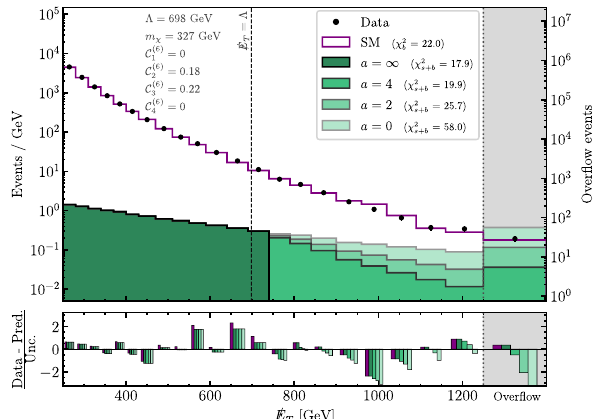
Fig. 9 Top panel: Examples of missing energy spectra for the CMS monojet search [95], illustrating different choices for imposing an EFT validity requirement on the signal prediction. For / E T > (cid:2) , we scale the / E (/ E /(cid:2)) − a as described in Sect. 2.2. T signal spectrum with the factor T The green distributions show the resulting signal predictions for four different choices of a , from a = 0 (lightest green), corresponding to no modificationofthespectrum,to a → ∞ (darkestgreen),whichremoves anysignalcontributionin / E T binsabove / E T = (cid:2) .TheSMbackground prediction (purple) and the observed event counts (black points) are taken from Ref. [95]. The last bin, starting at / E T = 1250GeV, con- tains any overflow and is thus not normalised to a given bin width. Bottom panel: A small bar chart per bin showing the pulls, defined as ( data − prediction )/ uncertainty,resultingfromaddingtheindicatedsig- nal prediction on top of the SM background prediction. The uncertainty includes the background uncertainty, signal uncertainty and statistical data uncertainty, added in quadrature. The purple bars show the pulls when only including the SM background prediction. The χ 2 values in the top panel legend correspond to the sum of the squared pulls in each case. These values are intended for illustration only, i.e. they do not correspond directly to − 2ln L CMS where L CMS is defined in Eq.